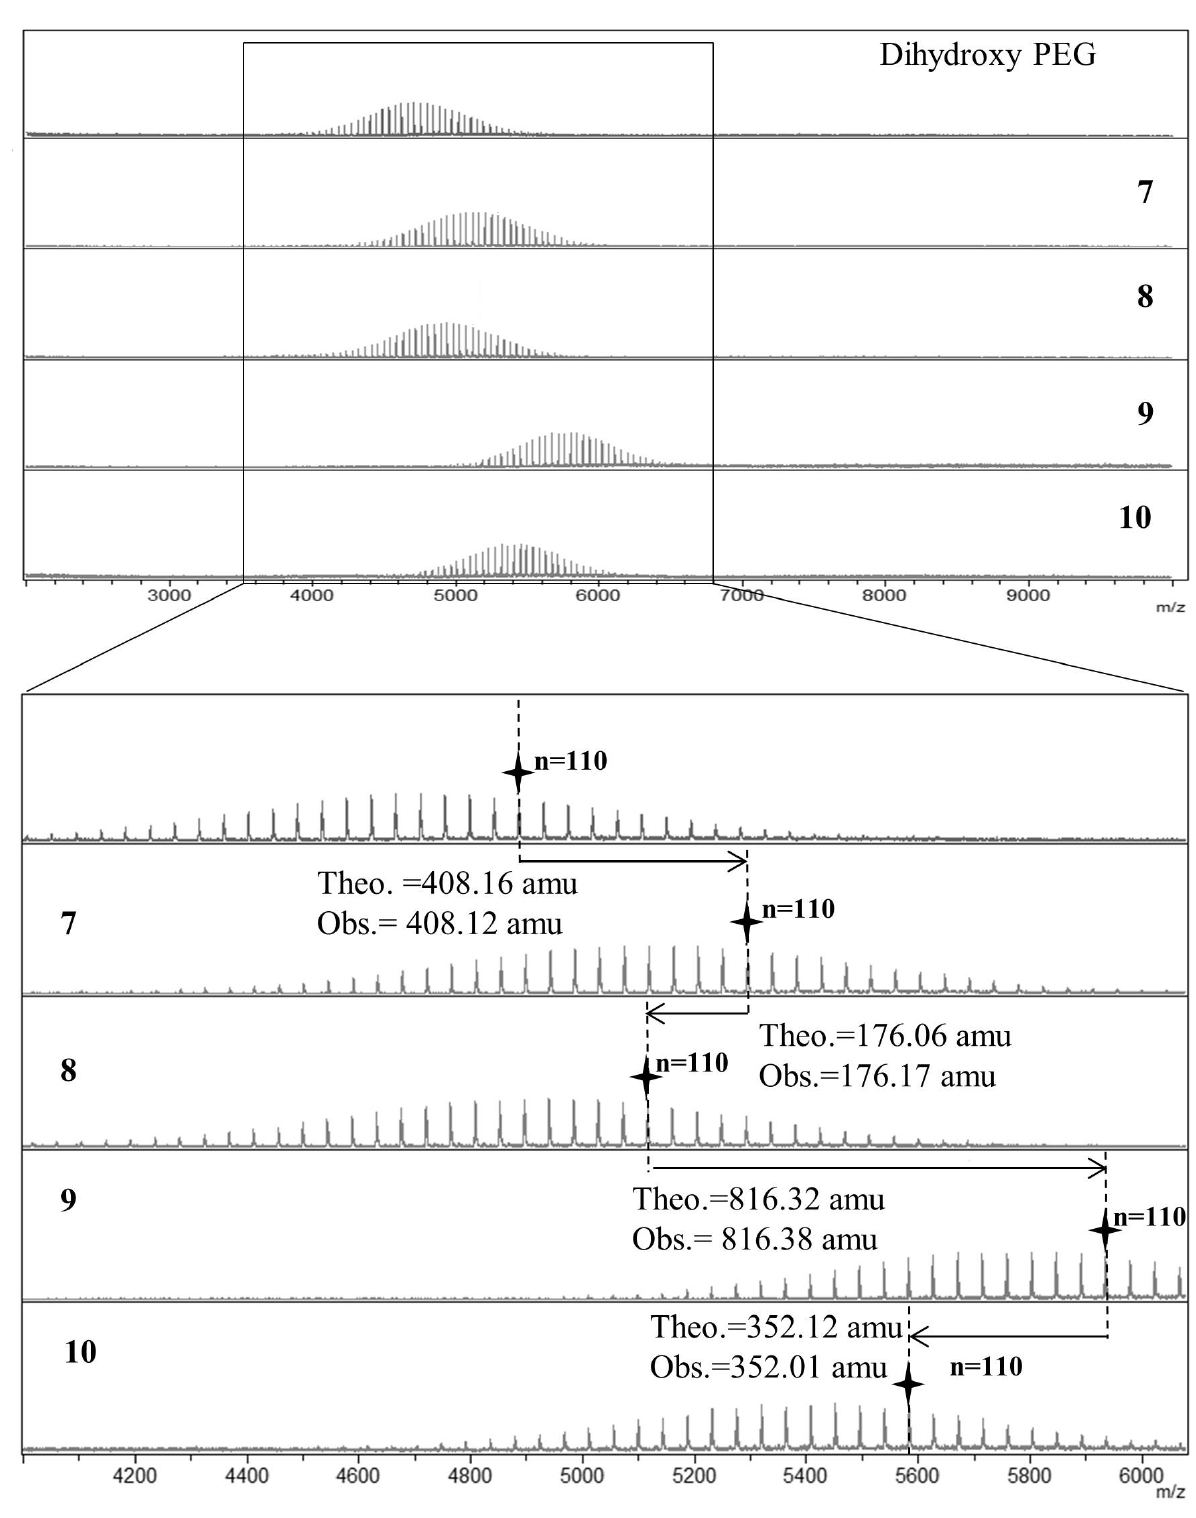
FIGURE 7 - MALDI-ToF mass spectra of the dihydroxy PEG after each reaction (starting material and compounds 7-10). Monintoring the dendritic growth for a polymer with 110 repeat units is highlighted to demonstrate the accuracy and utility of MALDI-ToF MS as a characterization